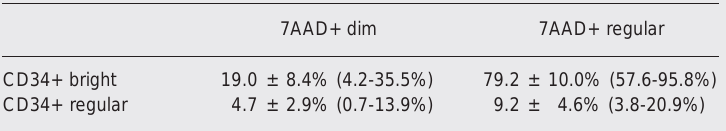
Table 2. Qualitative analysis of bright CD34+ cells or CD34+ cells with regular fluorescence in relation to labeling with 7AAD.